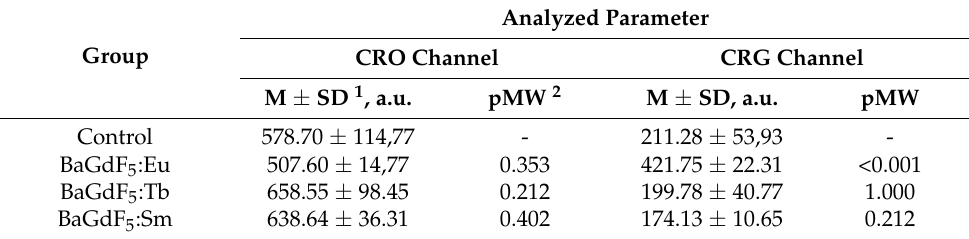
Figure 9. The histograms of cell distribution by nCRG+ signal intensity (ROS levels of mitochondria and nuclei normalized by cell size) of K562 cells in the control group and after exposure to synthesized nanoagents with the final concentration of 50 µ g/mL for 1 h. Table 2. CRO and CRG signals intensity in the studied cells after exposure to 50 µ g/mL of nanoagents for 1 h and in the control